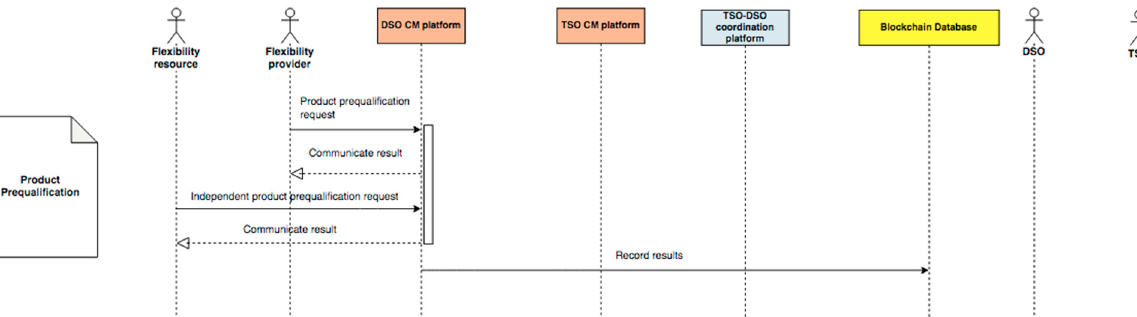
Figure 12. Product qualification and predelivery test.